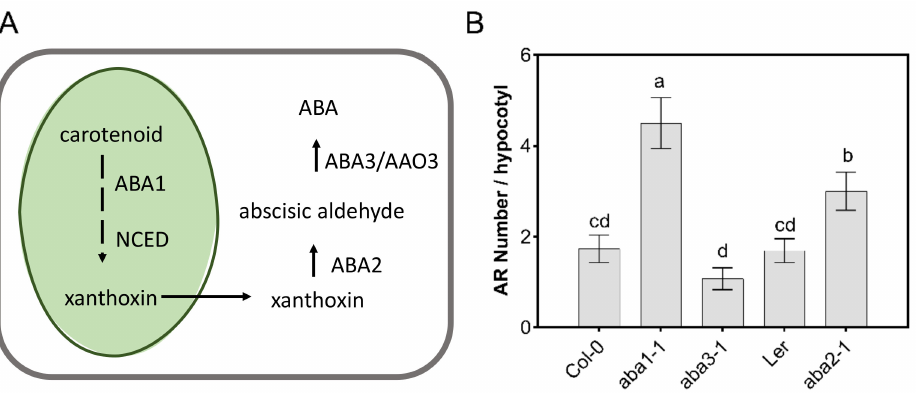
Figure 2. ABA biosynthesis mutants enhance hypocotyl adventitious root formation. ( A ) Scheme of ABA biosynthetic pathway in higher plants with indication of enzymatic conversions affected by mutants that were analyzed. NCED, 9-cis-epoxycarotenoid dioxygenase; AAO, ABA-aldehyde oxidase. ( B ) Adventitious root analysis (number per hypocotyl) in ABA biosynthesis mutants. Recordings were conducted 10 days after de-etiolation. Data, represented as mean values ± se, were obtained from plants grown in three independent experiments ( n = 20–25). Statistics were calculated using ANOVA, where mean values with different letters are significantly different at p ≤